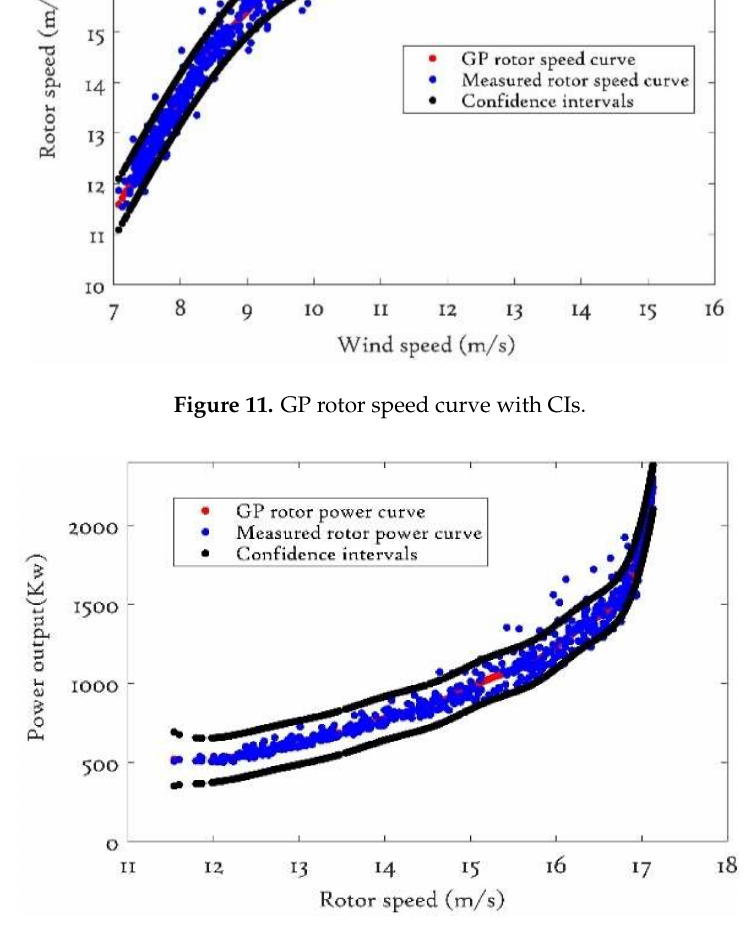
Figure 12. GP rotor power curve with